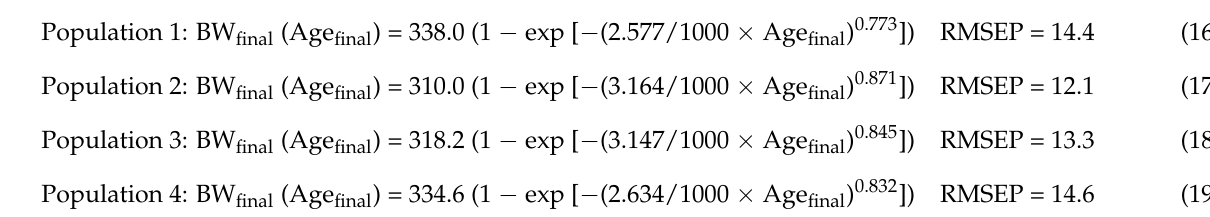
Modelling BW final as a function of Age final using the generalized Weibull model: